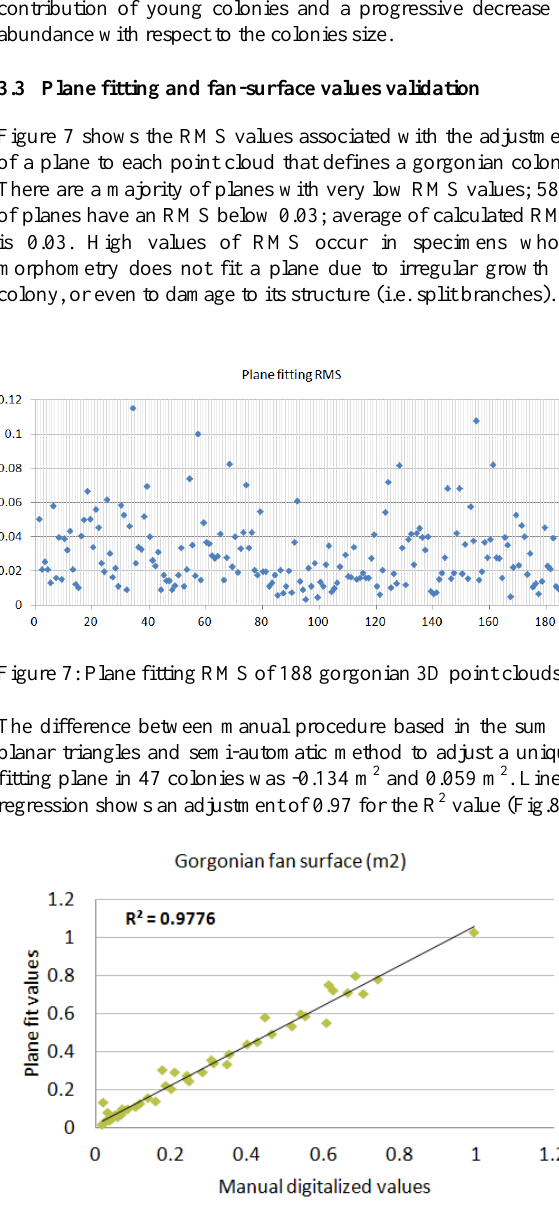
Figure 8: Correlation between Placogorgia sp. manual digitalized area in 3D point cloud and plane fit with semi- automatic